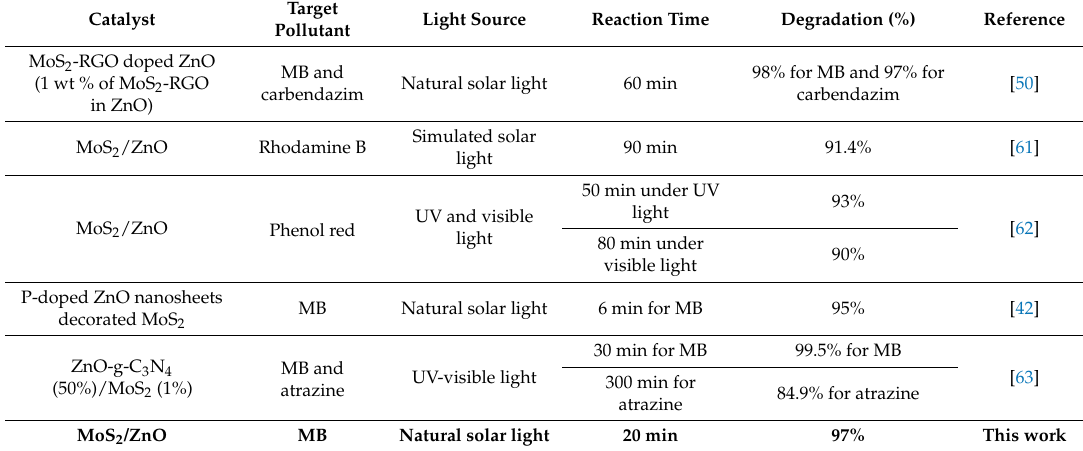
Table 1. Comparison of photocatalytic efficiency of MoS 2 /ZnOheterostructures for the degradation of pollutants in the presence of different light